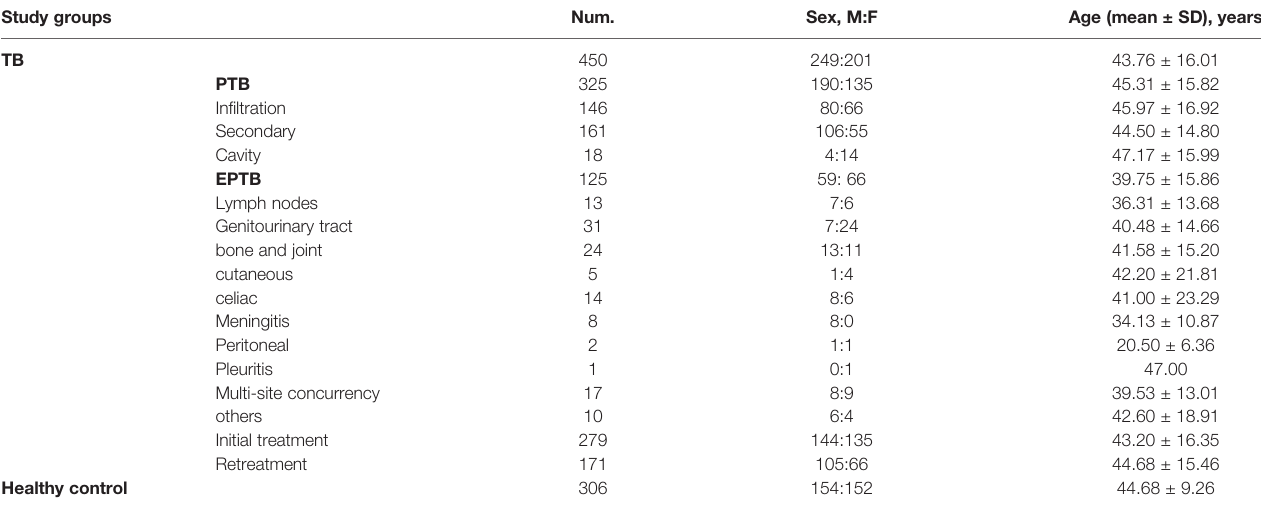
TABLE 1 | Demographic and clinical data for tuberculosis patients and controls. Study groups